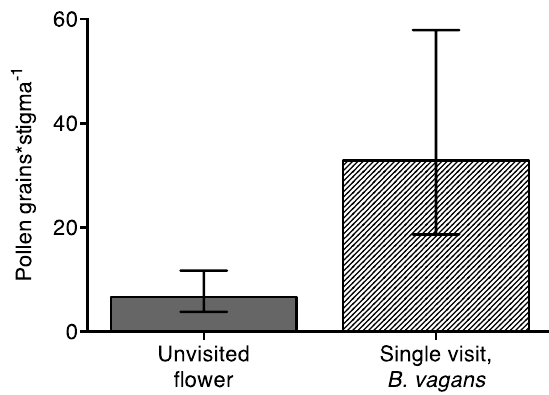
F IGURE 4. Least square means ± SE pollen grains present on stigmas of unvisited flowers and those that had received single visits from Bombus